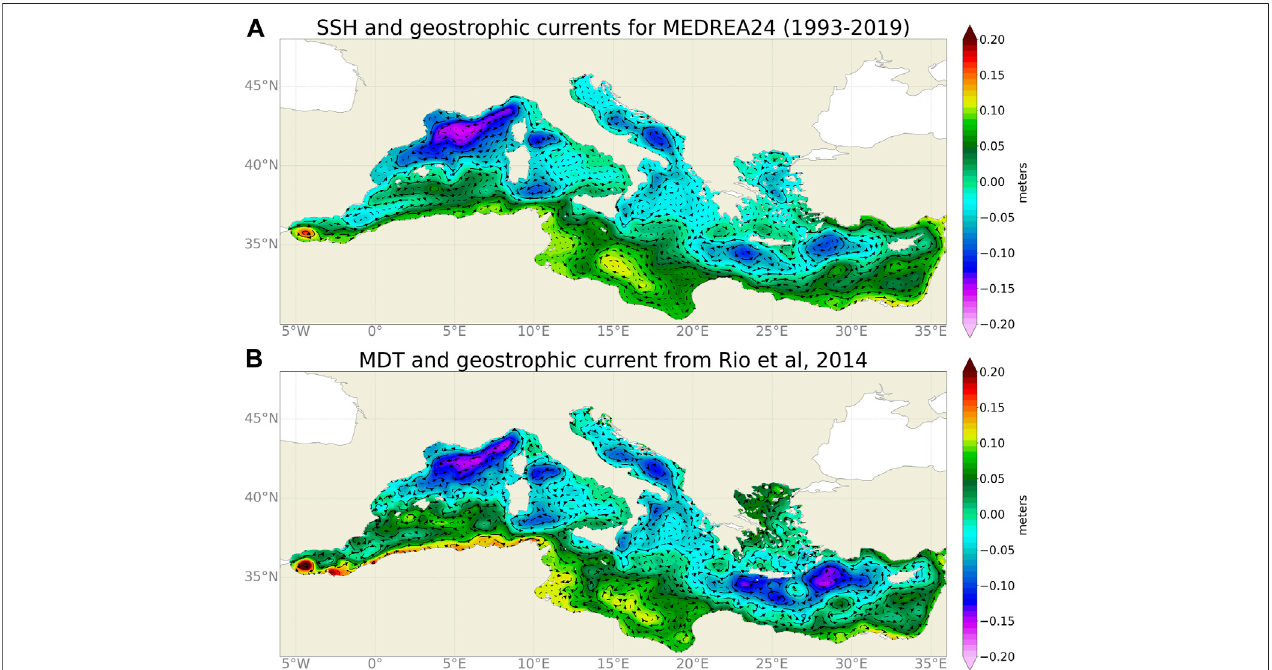
FIGURE 12 | Mean SSH and associated geostrophic currents for MEDREA24 during the period 1993 – 2019 (A) and Mean Dynamic Topography (B) used for the SLA assimilation. A global constant has been removed in the basin in both plots.